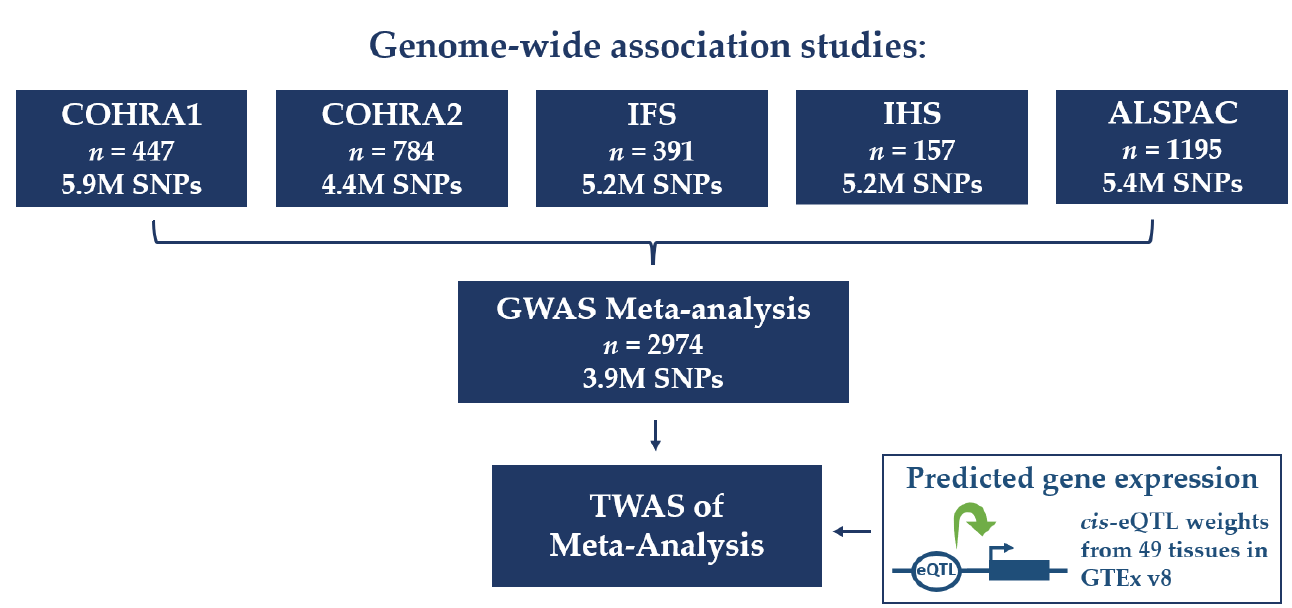
Figure 1. Flowchart of analyses performed. Genome-wide association studies (GWASs) of early child- hood caries (ECC) were performed separately in five cohorts and meta-analyzed. The transcriptome- wide association study (TWAS) was performed using meta-analysis summary statistics integrated with predicted gene expression derived from common cis expression quantitative trait locus (eQTL) weights from multivariate adaptive shrinkage (MASHR) models across 49 tissues from Genotype- Tissue Expression (GTEx) project. TWAS analyses were performed in individual tissues in S-PrediXcan and meta-analyzed in S-MultiXcan.